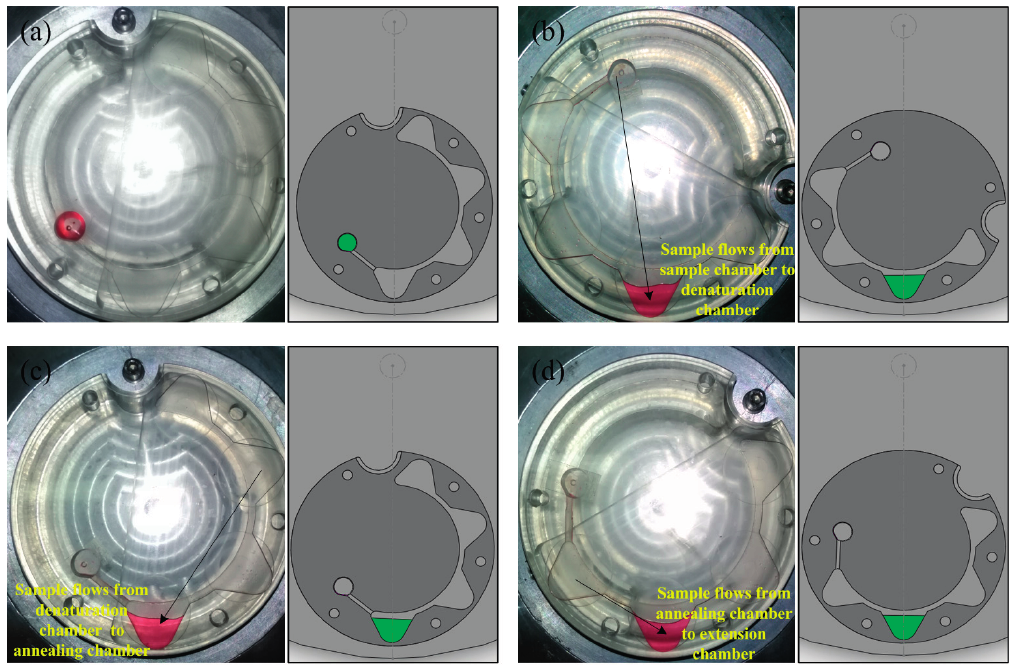
Figure 5. Images and schematics of fluid flow through the three PCR chambers. ( a ) The initial position of the PCR disc; ( b ) 40- μ L reaction mixture was pumped to the denaturation chamber from the sample chamber; ( c ) 40- μ L reaction mixture was pumped to the annealing chamber from the denaturation chamber; ( d ) 40- μ L reaction mixture was pumped to the extension chamber from the annealing